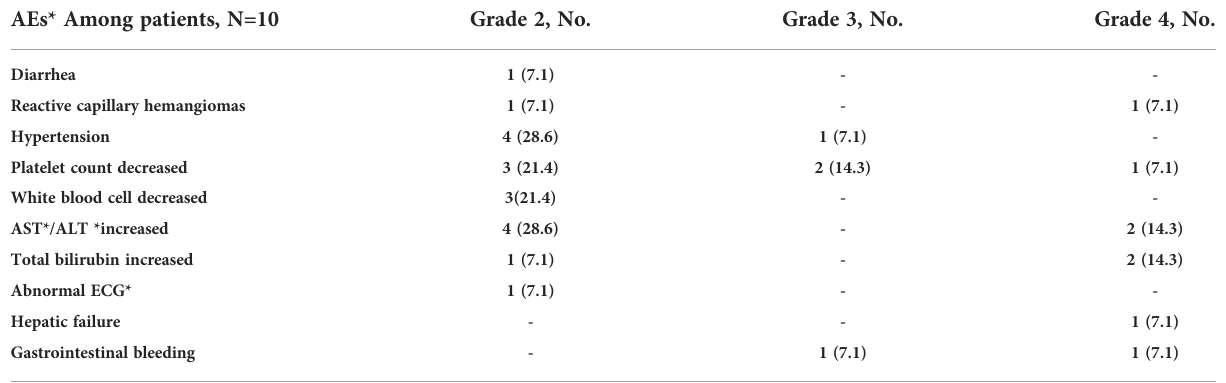
TABLE 3 Treatment-related adverse events